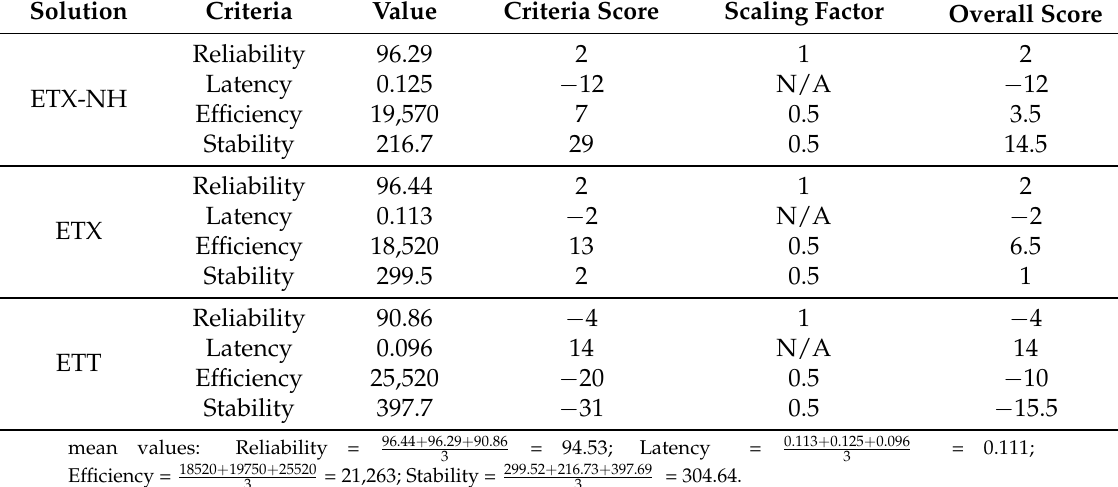
Table 5. Scoring the criteria for each